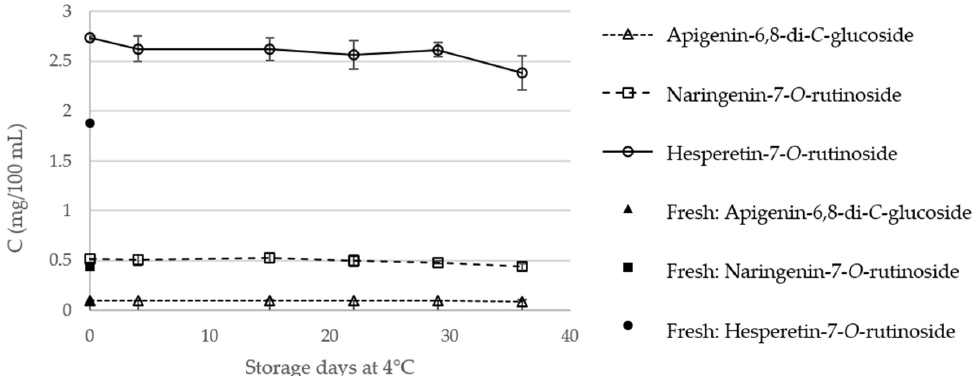
Figure 7. Individual phenolic compounds content (mg/100 mL) of fresh and high-pressure processed (HPP) orange juice during storage at 4 ◦ (HPP) orange juice during storage at 4 °C.